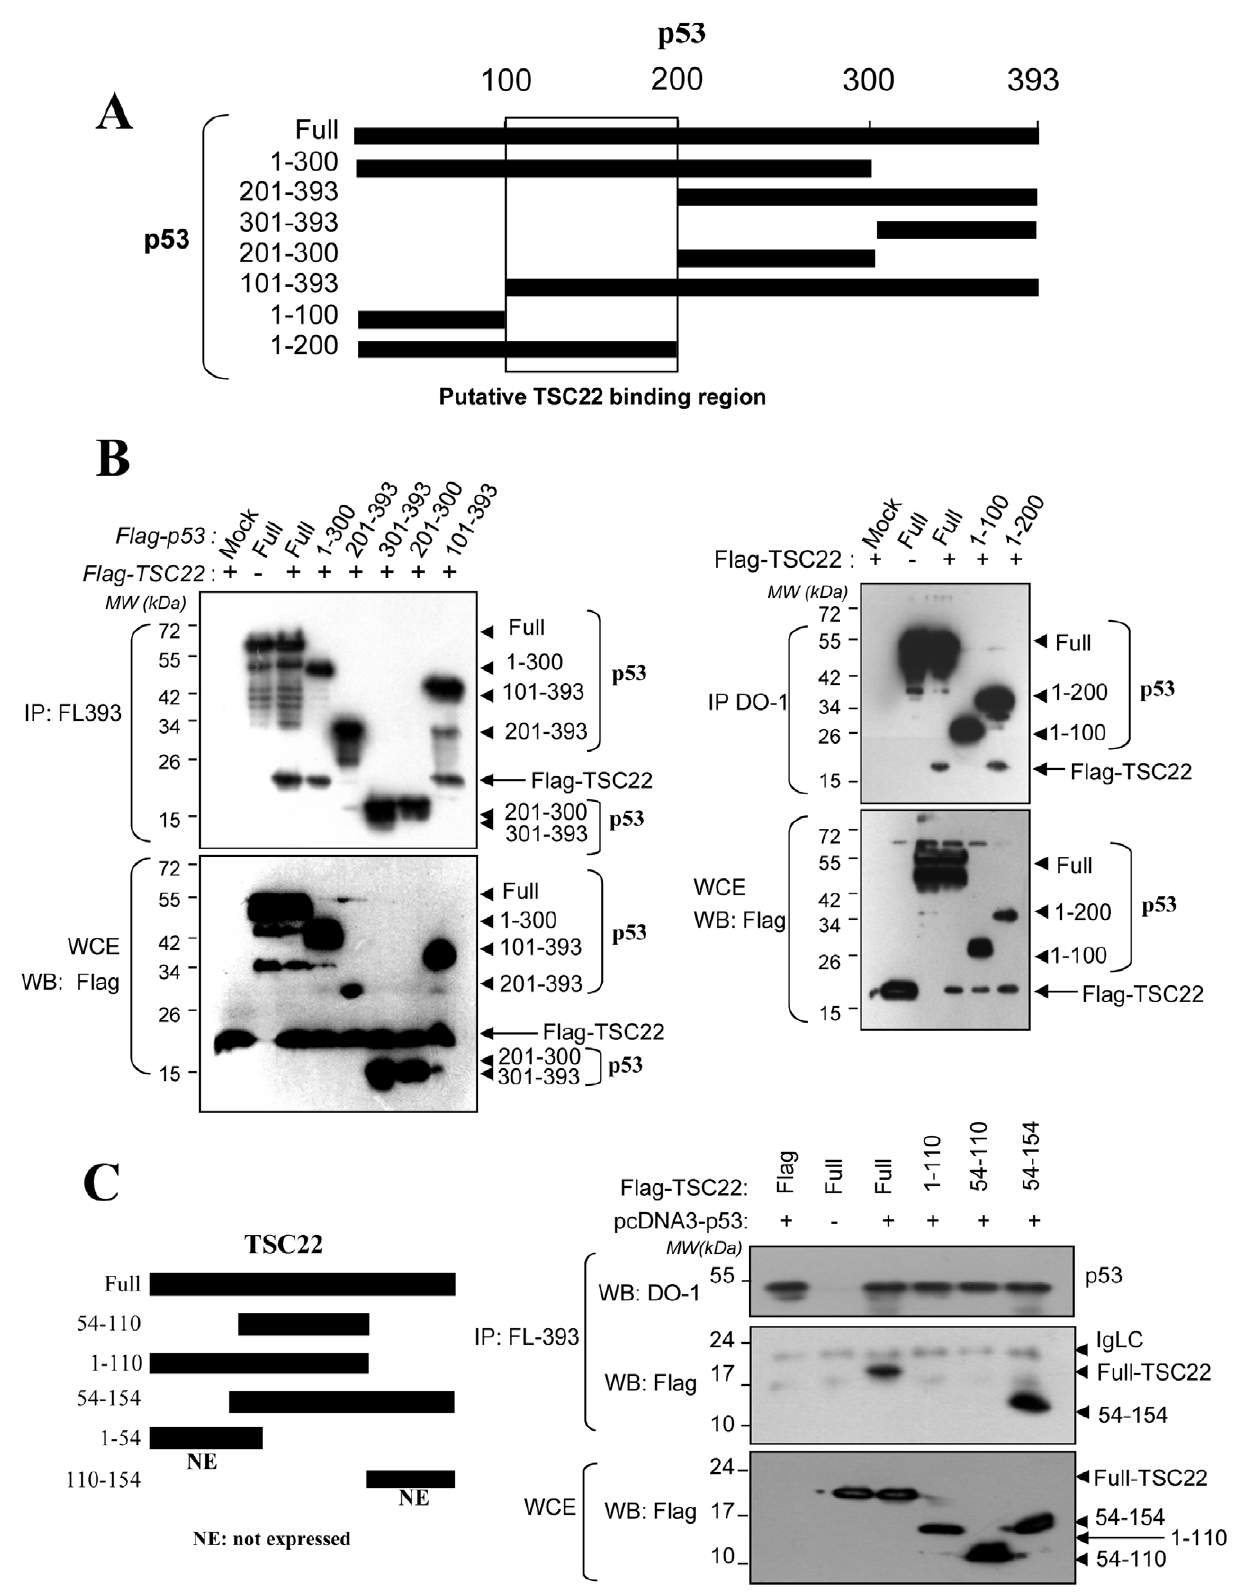
Figure 4. Mapping of the binding regions in TSC-22 and p53. ( A ) Schematic diagram shows the cDNA constructs for the Flag-tagged p53 deletion mutants and full-length p53, and indicates the TSC22 binding domain. ( B ) H1299 cells were transfected with the indicated plasmids encoding Flag-tagged p53 deletion mutants along with the Flag-TSC-22 plasmid. Cell lysates were immunoprecipitated with the anti-p53 polyclonal